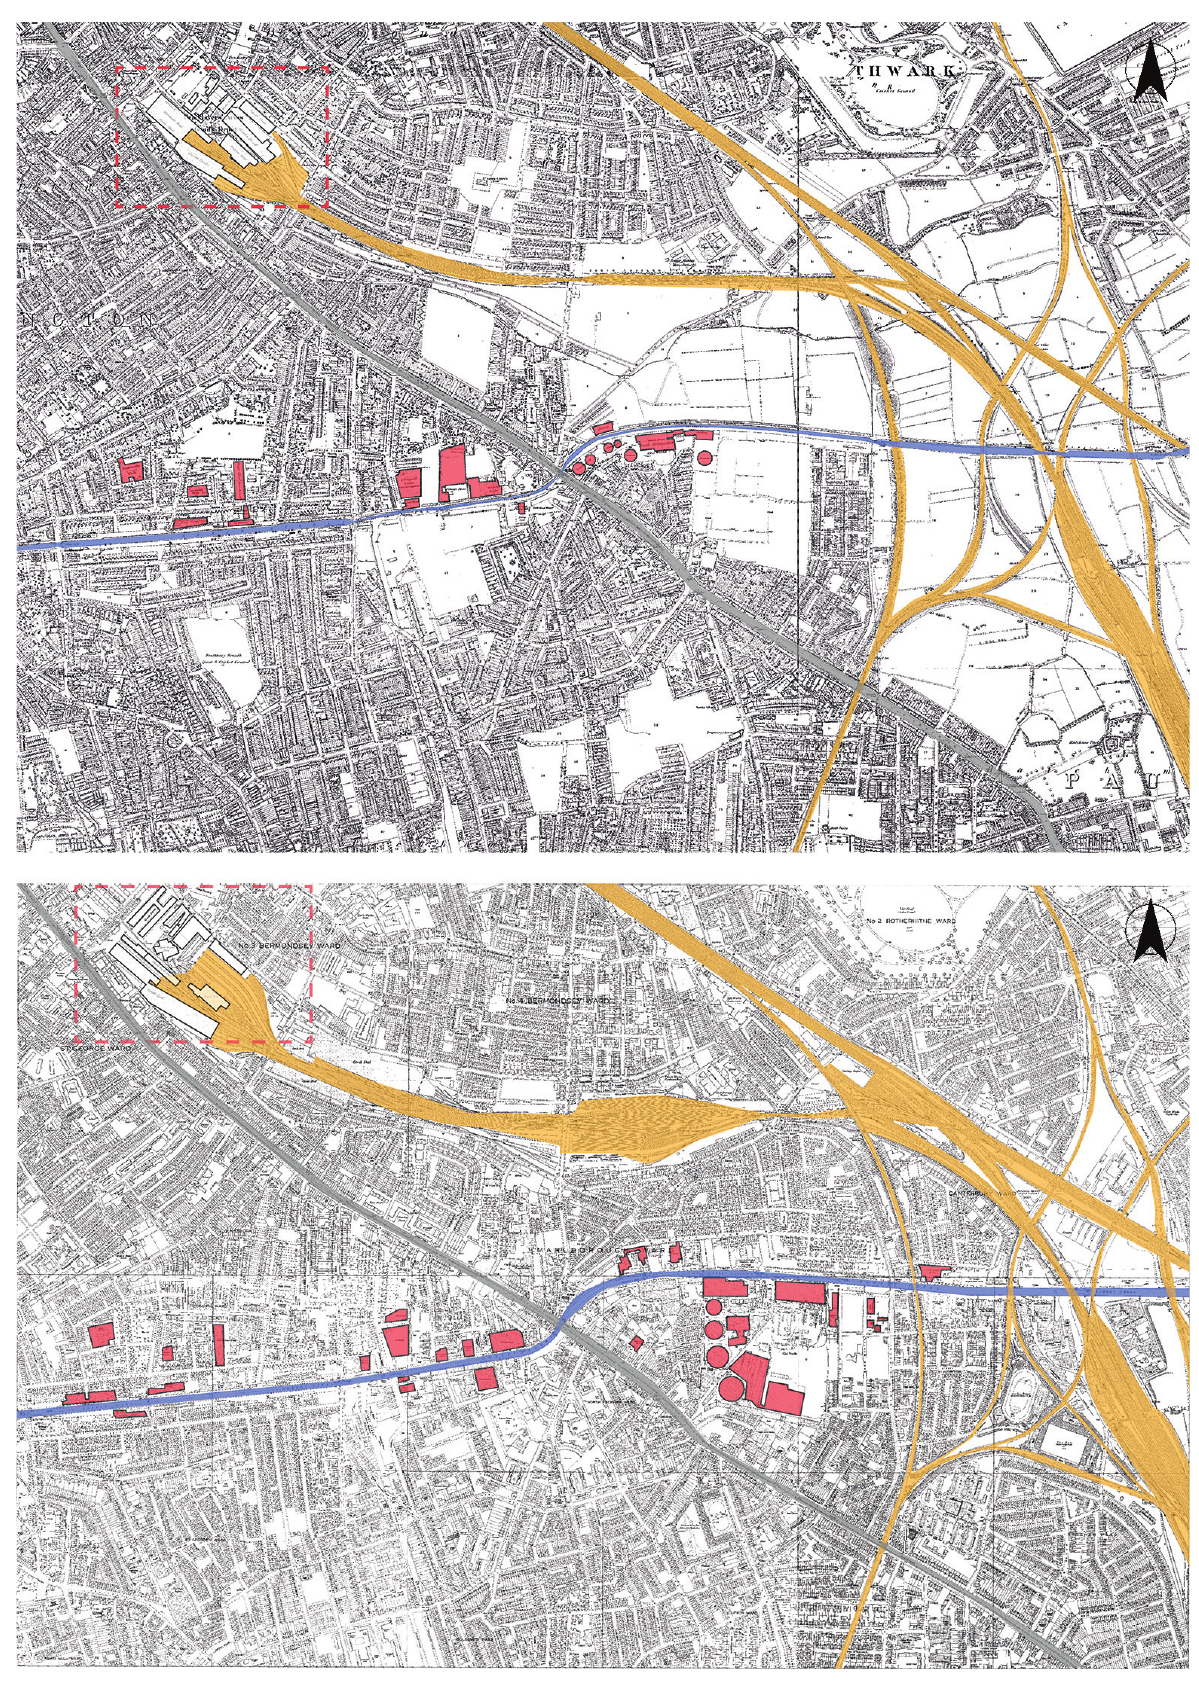
Figure 3. Historical maps of Old Kent Road: 1896 (top) and 1952 (bottom). Highlighted in blue is the Grand Surrey Canal; in orange, the railway; in grey, Old Kent Road; in red, manufactories, industrial buildings, and workshops; and, in white, the Bricklayers Arms Station and Depot. Source: Ordnance Survey (2019). Created 12 July